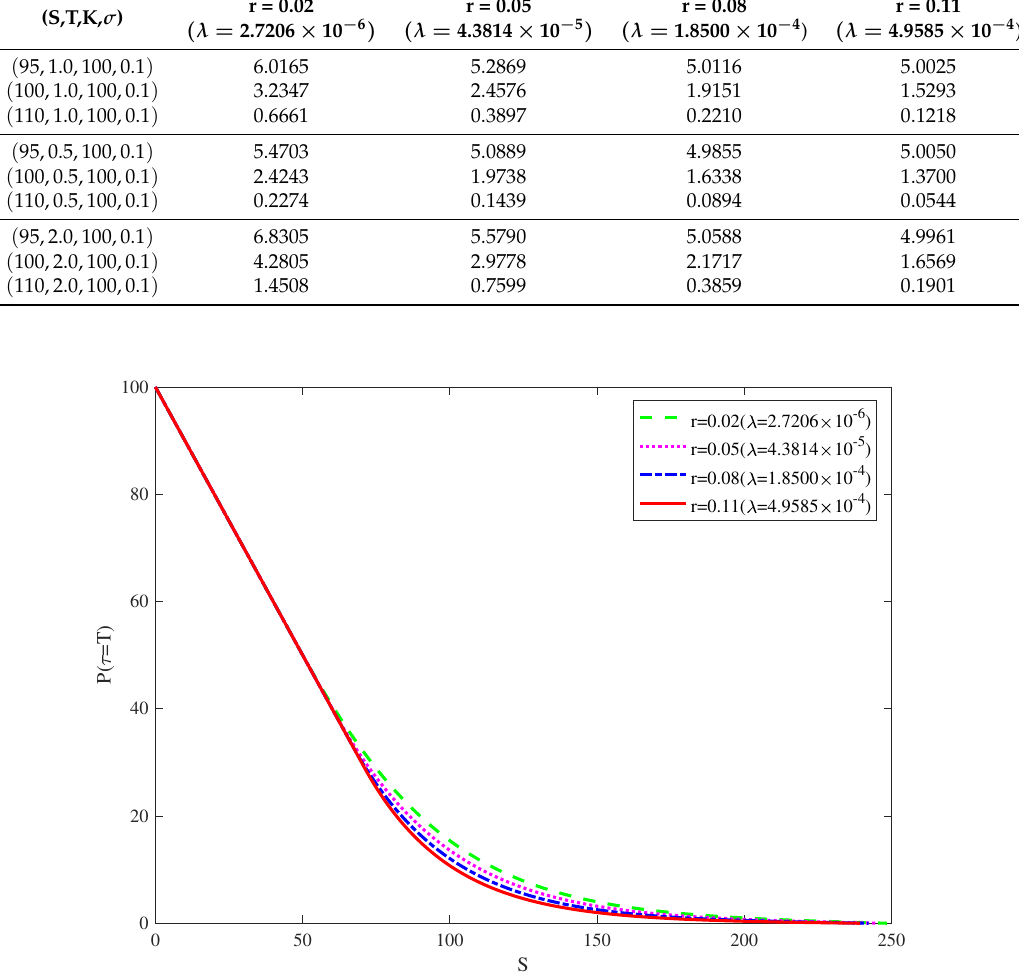
Figure 4. American put option values for different values of r (and λ ). ( T = 1, σ = 0.1, K =